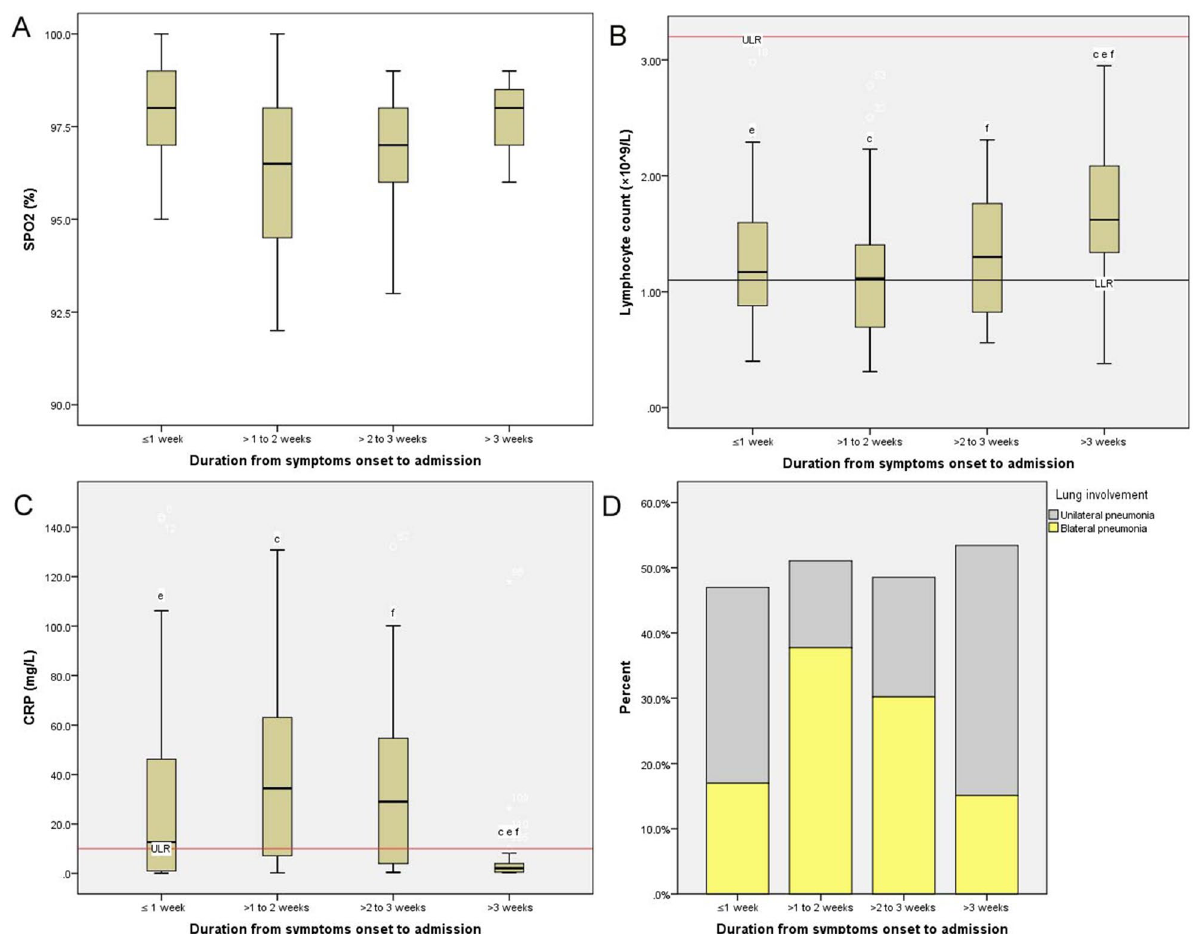
Figure 3. Simulative changes of SpO 2 , lymphocyte count, CRP, and radiological findings in non-severe patients with COVID-19 across the four groups. COVID-19 patients who were in the second week after symptoms onset presented the highest levels of CRP and the lowest levels of SpO 2 and lymphocyte count. Meanwhile, the patients had the highest incidence of bilateral pneumonia. SPO 2 , pulse oximeter O 2 saturation; CRP, C-reactive protein; ULR, Upper limit of reference intervals; LLR, Lower limit of reference